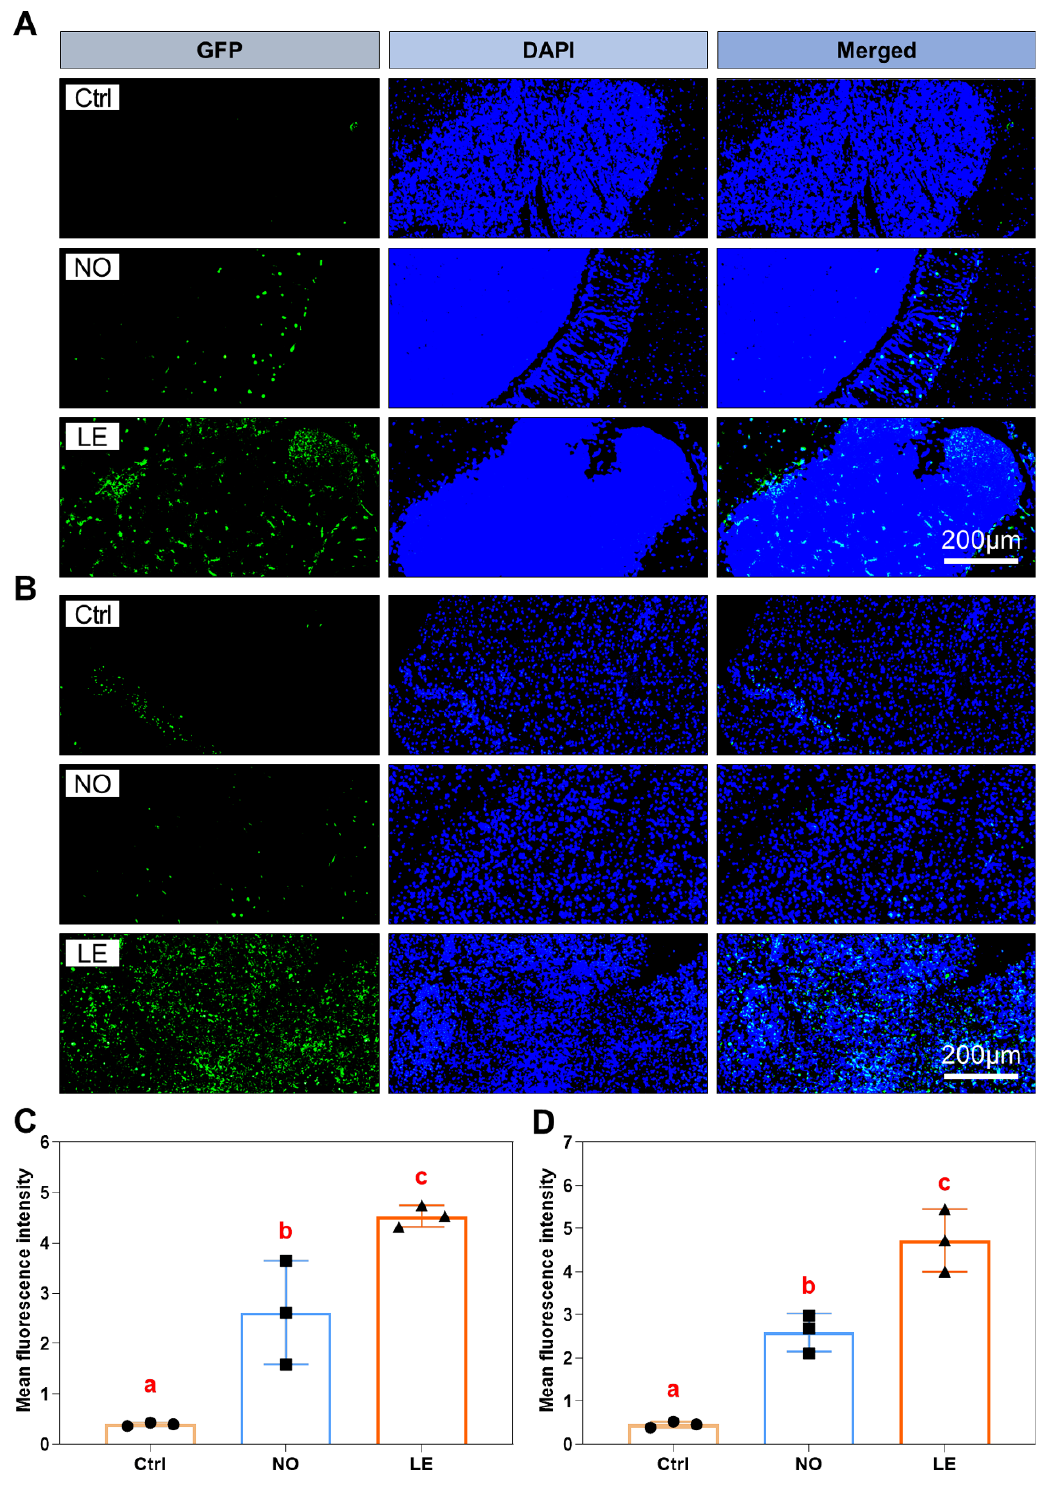
Figure 8. Exposure to acute cold stress resulted in severe cell apoptosis in the brain and liver of Nile tilapia. ( A , B ) Photographs indicating apoptotic cells in the brain ( A ) and liver ( B ) sections. Sample numbers for the Ctrl, NO and LE groups are as follows: brain 3, 3, 3; liver 3, 3, 3. ( C , D ) Bar charts illustrating intensity of TUNEL signal for the brain ( A ) and liver ( B ) sections. The dots, squares and triangles represent data of the corresponding experimental groups shown in the horizontal axis. The error bars represent SD ( n = 3). Different letters above the error bars indicate significant difference between the means ( p ≤ 0.05 ).